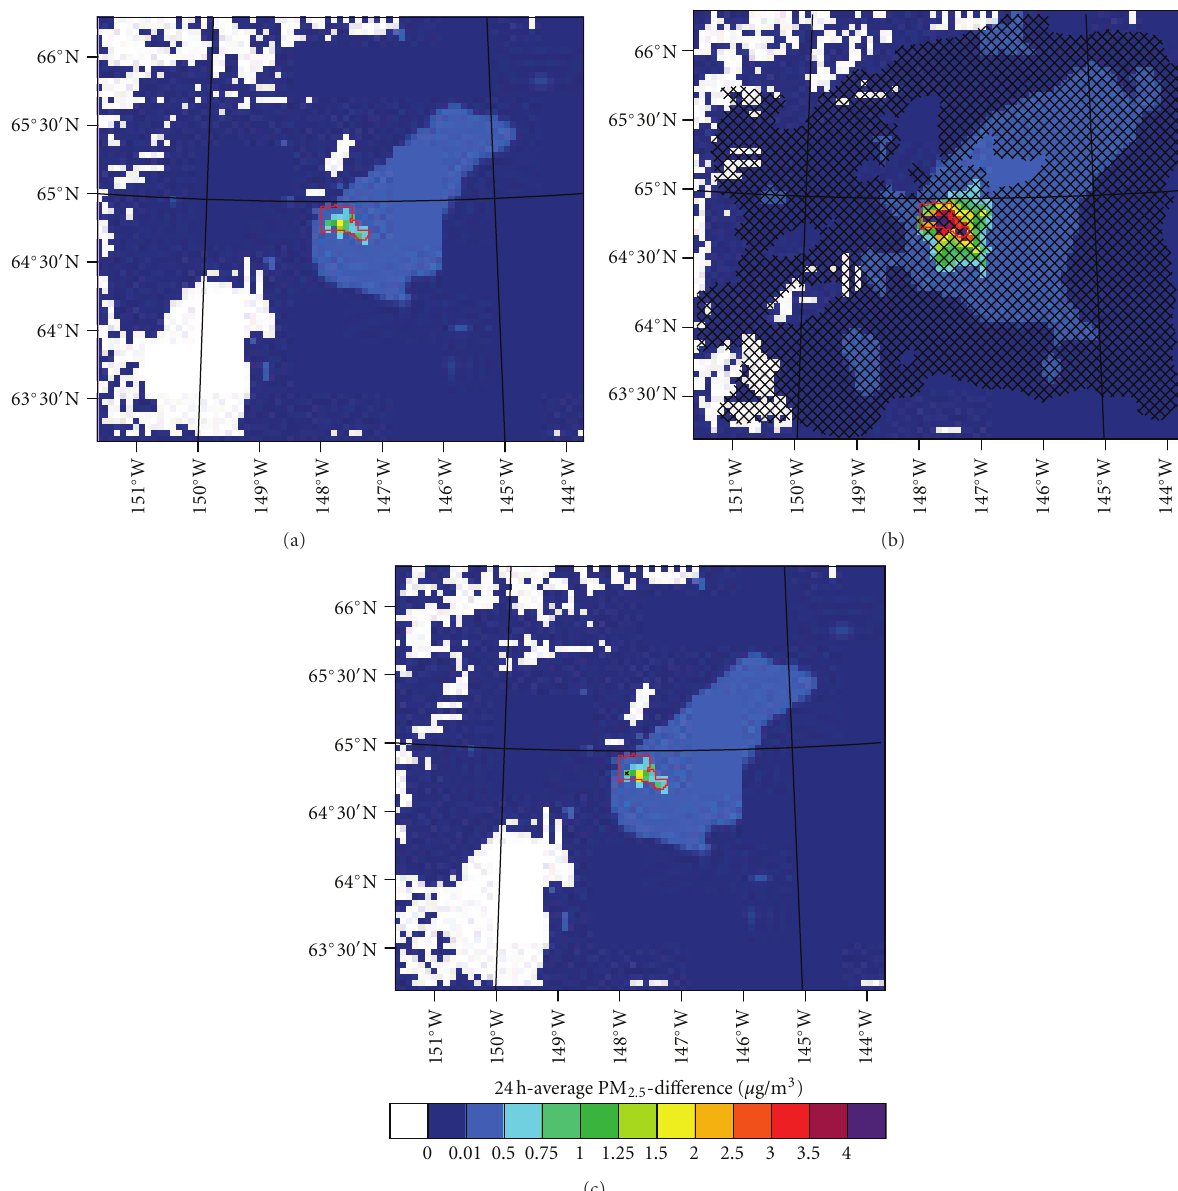
Figure 6: Like Figure 5, but for 24 h-average PM 2 . 5 di ff erences (a) REF-WSR, (b) REF-WSS1, and (c) REF-WSS2 from October 1 to October 14 2008